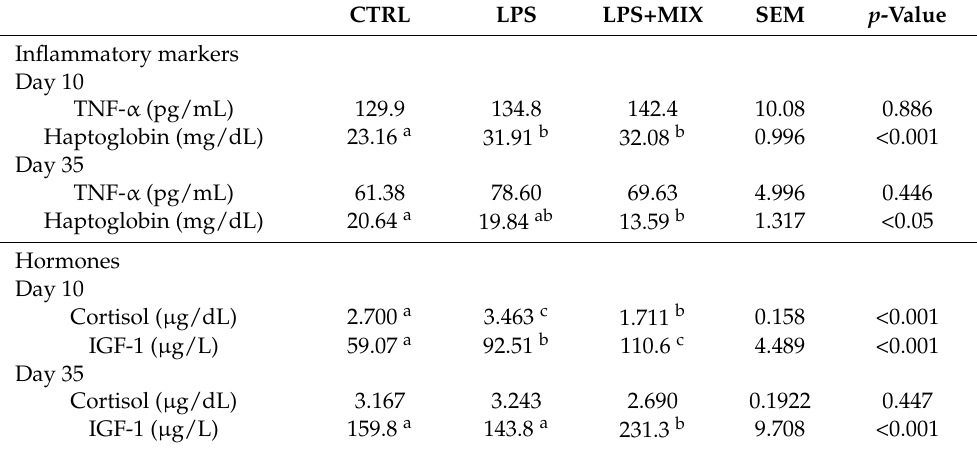
Table 3. Effect of treatments on inflammatory markers and hormonal status.